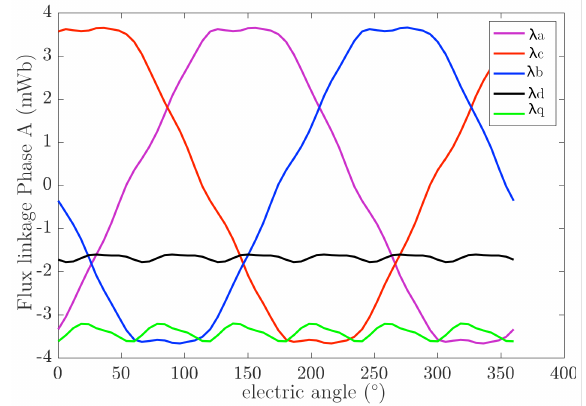
Figure 13. Flux linkage vs. rotor position for ψ = 70 ◦